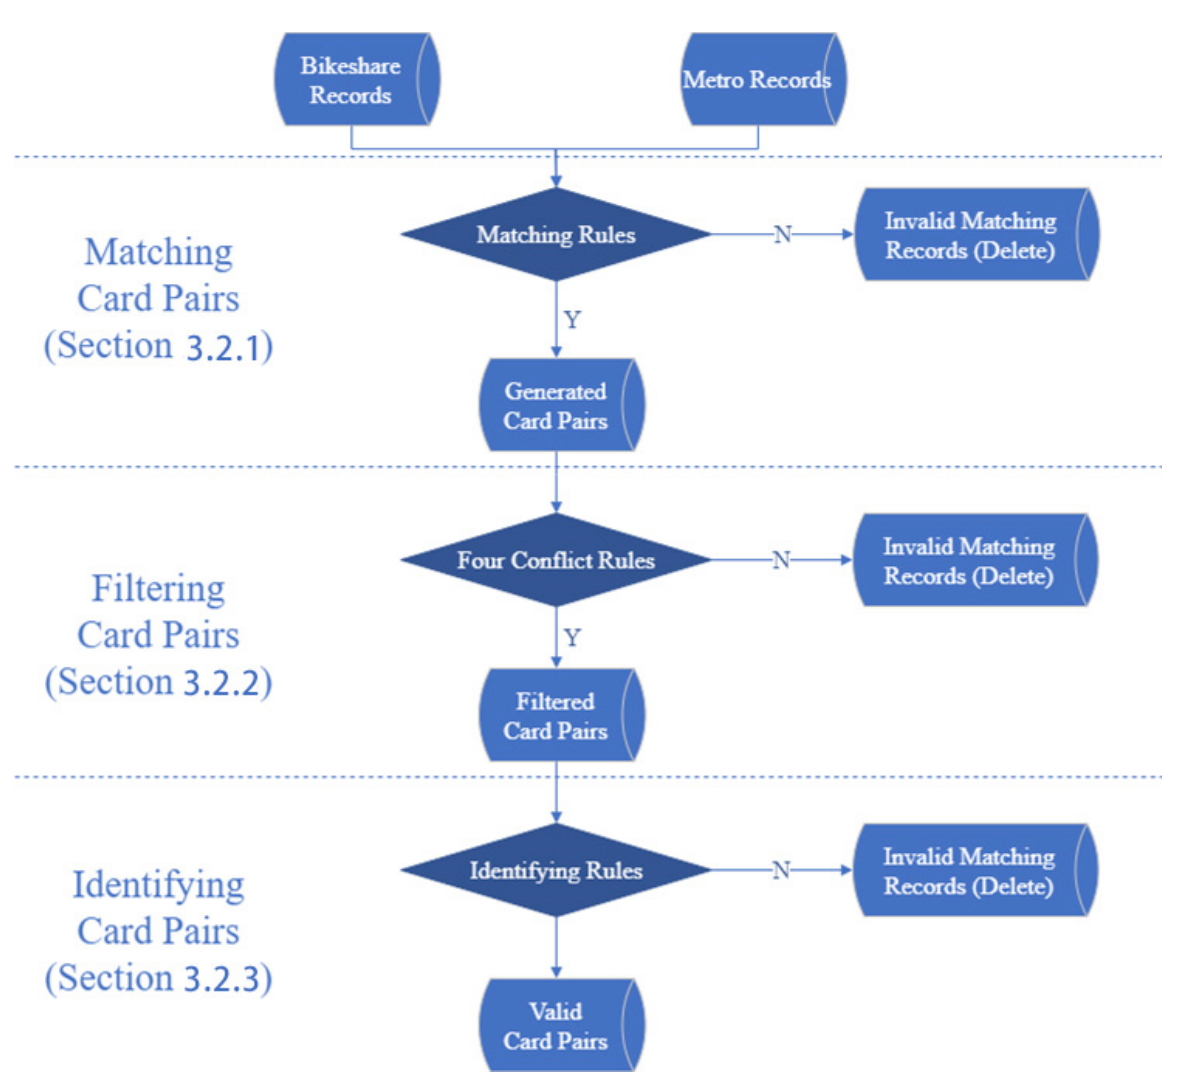
Figure 2. Flowchart of the identification process. Algorithm 1: Generation of Metro-Bikeshare Trips